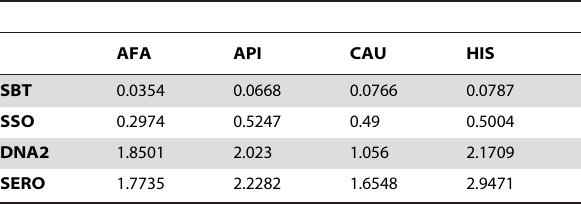
Table 4. Average allele entropy for all typing methods and all population